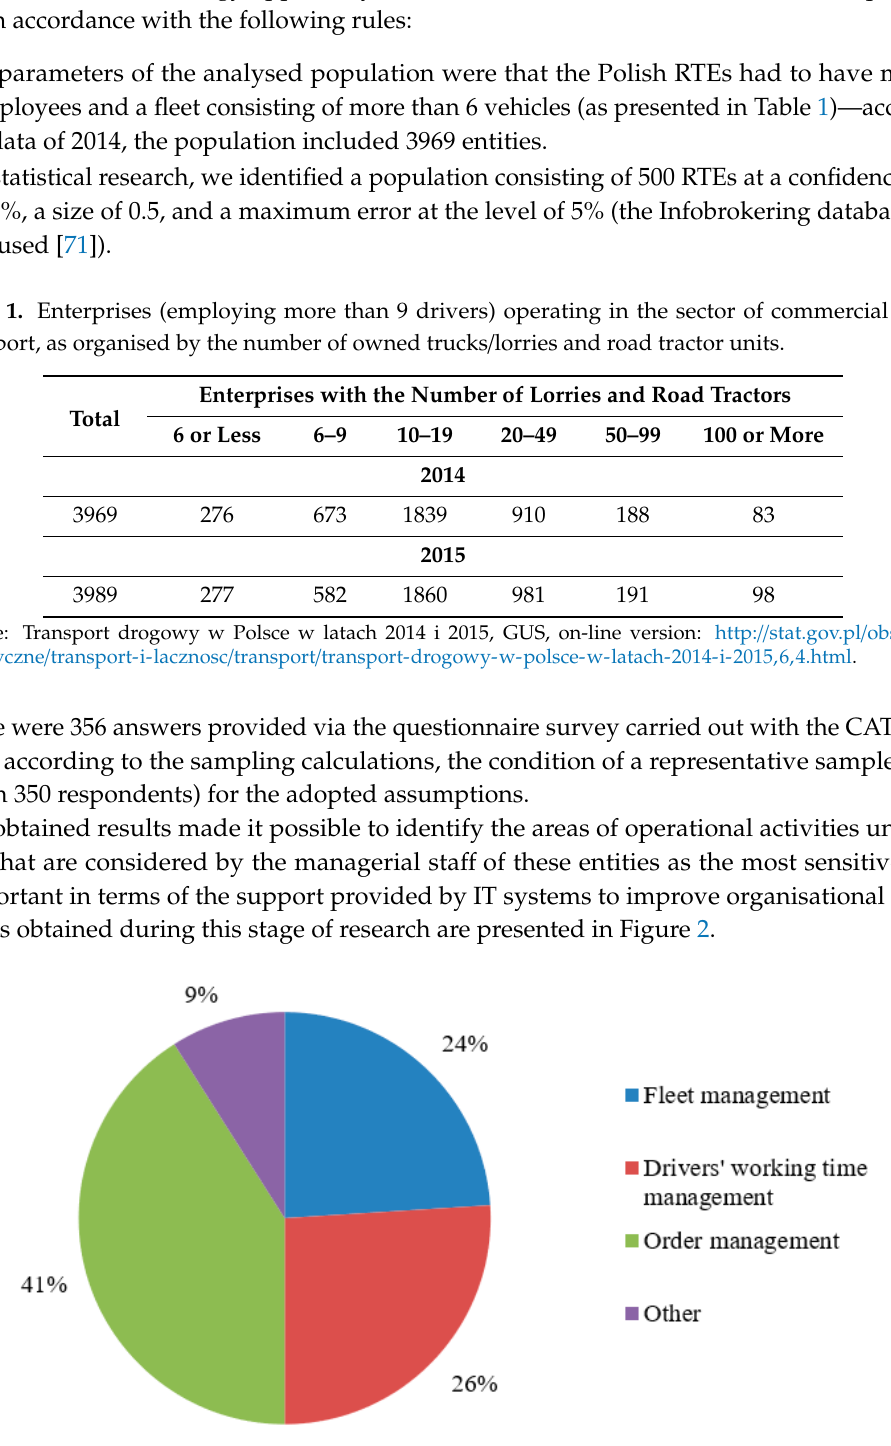
Figure 2. The fields of operational activities undertaken by the analysed enterprises that prove to be the most sensitive in terms of the support provided by IT